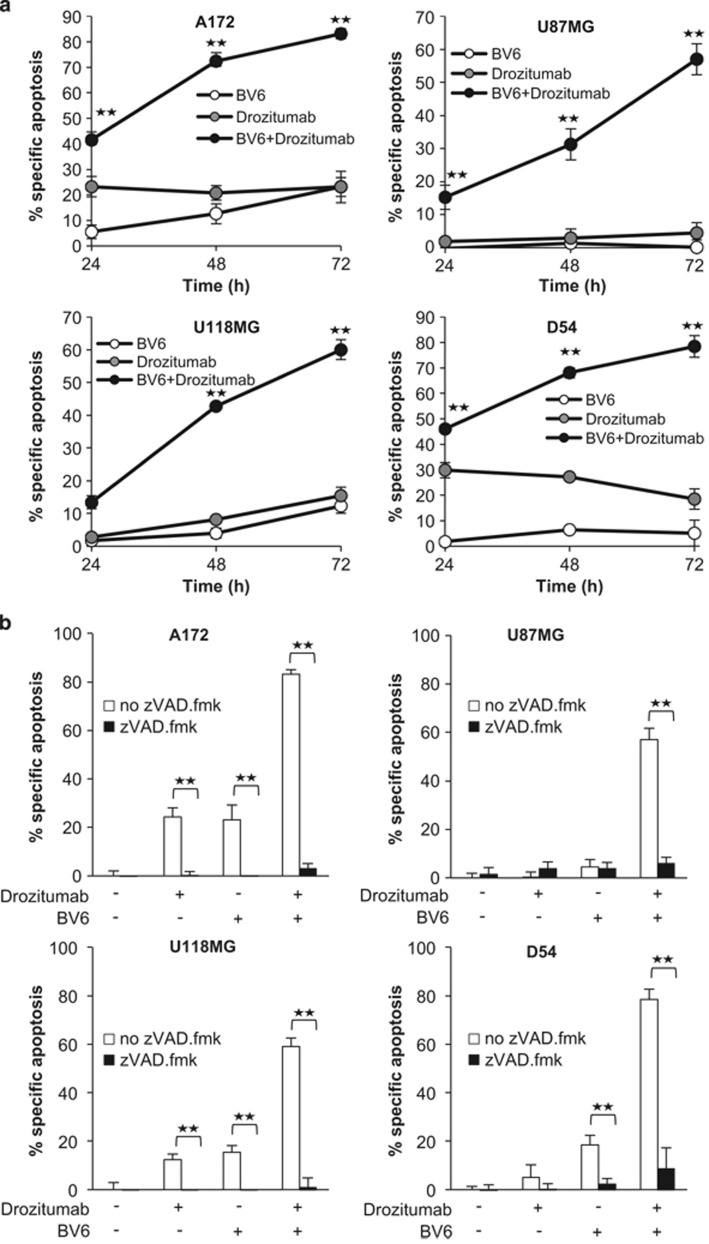
BV6 cooperates with Drozitumab to trigger caspase-dependent apoptosis. (a) Glioblastoma cells were treated for 24, 48 and 72 h with Drozitumab (U87MG: 5 μg/ml; A172, D54: 0.3 μg/ml; U118MG: 10 μg/ml) and/or BV6 (U87MG: 4 μM; A172: 3 μM; D54: 2 μM; U118MG: 1 μM). DNA fragmentation of propidium iodide-stained nuclei was determined by FACS analysis. Mean + S.E.M. values of three independent experiments performed in triplicate are shown; **P<0.001. (b) Glioblastoma cells were treated for 72 h with Drozitumab (U87MG: 5 μg/ml; A172, D54: 0.3 μg/ml; U118MG: 10 μg/ml) and/or BV6 (U87MG: 4 μM; A172: 3 μM; D54: 2 μM; U118MG: 1 μM) in the presence or absence of 20 μM zVAD.fmk. DNA fragmentation of propidium iodide-stained nuclei was determined by FACS analysis. Mean + S.E.M. values of three independent experiments performed in triplicate are shown; **P<0.001. (c) Primary glioblastoma cells (GB1 and GB2) and glioblastoma stem-like cells (GBM10) were treated for 72 h with BV6 and/or Drozitumab (GB1: 8 μM BV6/0.6 μg/ml Drozitumab, GB2: 2 μM BV6/0.6 μg/ml Drozitumab, GBM10: 2.5 μM BV6/10 μg/ml Drozitumab). DNA fragmentation of propidium iodide-stained nuclei was determined by FACS analysis. Mean + S.E.M. values of three independent experiments performed in triplicate are shown; **P<0.001. (d) A172 (left panel) and U87MG (right panel) cells were treated for indicated times with 0.3 μg/ml (A172) or 5 μg/ml (U87MG) Drozitumab and/or 3 μM (A172) or 4 μM (U87MG) BV6. Caspase activation and Bid processing were analyzed by western blotting, arrowheads indicate cleavage fragments. A representative experiment of three independent experiments is shown